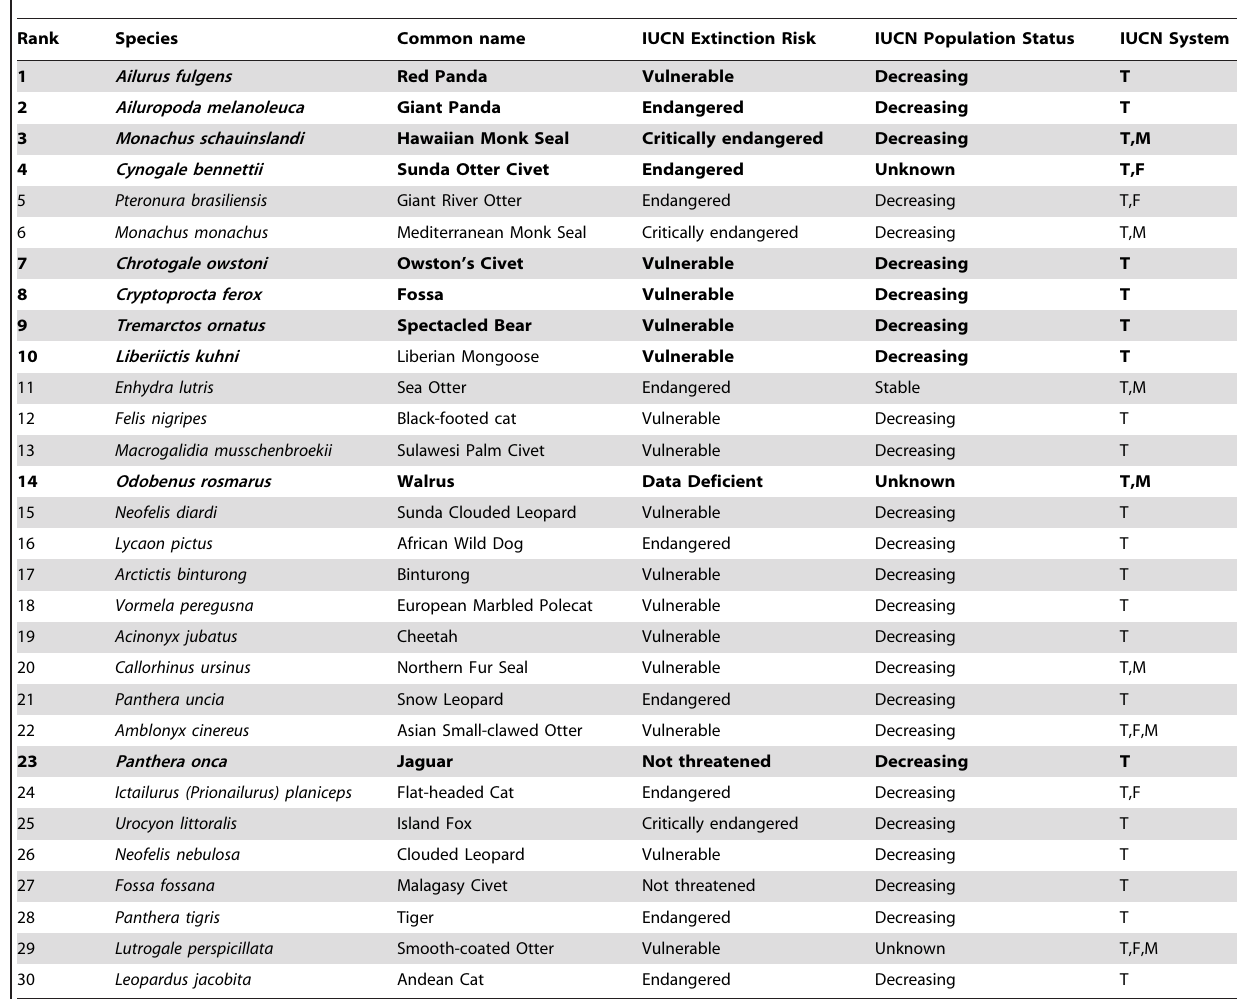
Table 2. Top 30 conservation priority of carnivore species according with HEDGE analysis of the ‘pessimistic’ transformed